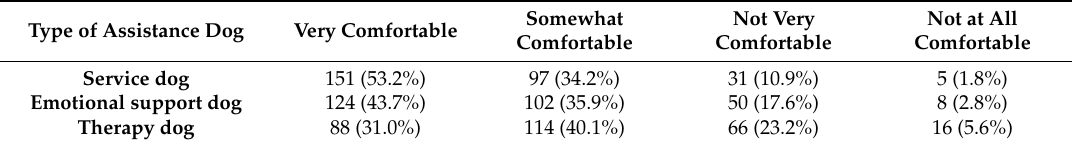
Table 2. Perceived confidence in defining various types of assistance